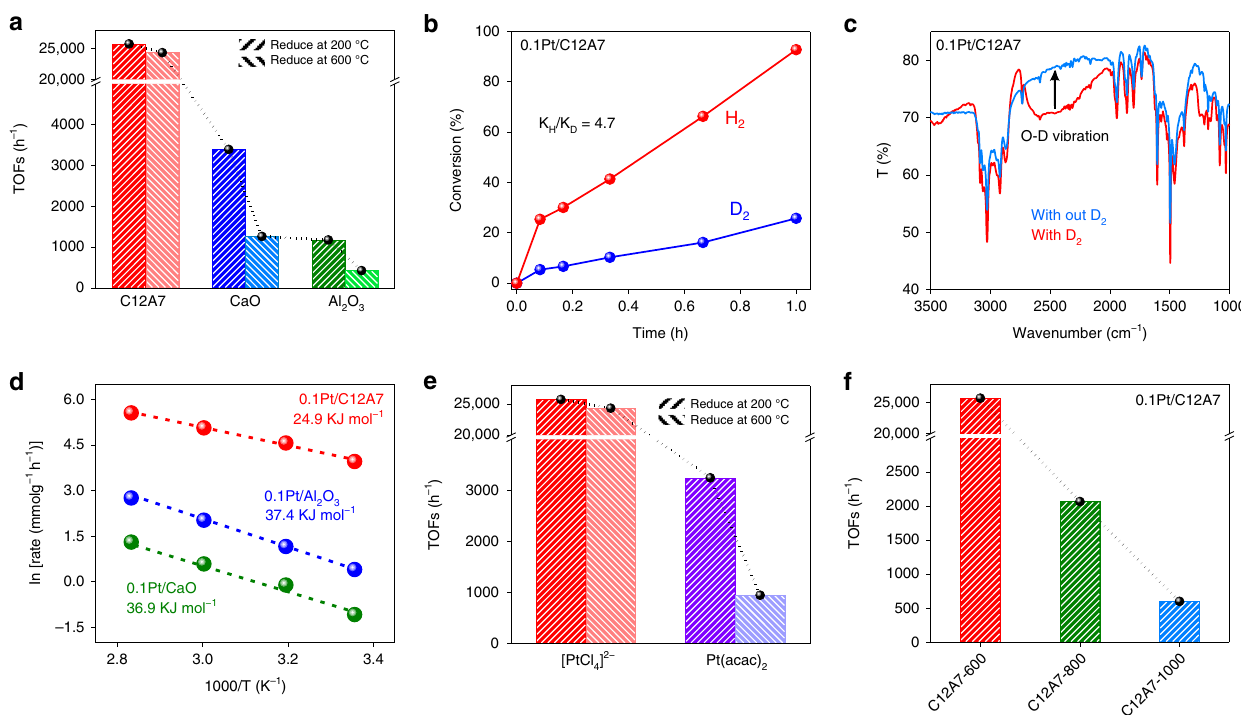
Fig. 4 Catalytic performance and related kinetic studies. a Plot of 0.1Pt loaded on various supports at elevated reduction temperatures and their TOFs for the hydrogenation of 4-chloronitrobenzene. b Primary isotope effect observed on 0.1Pt/C12A7 for the hydrogenation of 4-chloronitrobenzene. c FTIR spectra for 0.1Pt/C12A7 after exposure to D 2 with the arrow pointing the O-D vibration. This vibration disappears after the introduction of styrene. d Arrhenius plots for 0.1Pt loaded on various supports. e Plot of 0.1Pt/C12A7 with different Pt precursors at elevated reduction temperatures and their TOFs for the hydrogenation of 4-chloronitrobenzene. f Plot of 0.1Pt loaded on C12A7 support prepared at different calcination temperatures and their TOFs for the hydrogenation of 4-chloronitrobenzene. The TOFs was calculated from the reaction rate at a low conversion level. Reaction conditions: 5 mg catalyst, 0.5 mmol 4-chloronitrobenzene, 5 ml methanol, 60 °C, 0.5 MPa H 2 . The yields given below the structure were determined using GC and GC-MS with n- hexadecane as an internal